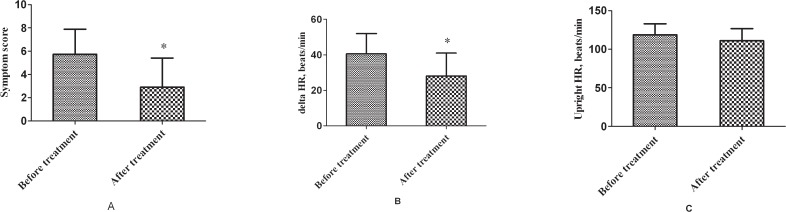
Symptom scores and heart rate changes of patients with POTS after metoprolol treatment.Compared to the symptom scores before treatment, the scores were significantly decreased after treatment in 34 children with POTS [(5.7 ± 2.2) vs. (2.9 ± 2.5), t = 9.232, P <0.001)]. Twenty-three patients repeated the head-up test, showing that the increment in heart rate induced by postural changes was significantly reduced after treatment [(41 ± 11) vs. (28 ± 13) beats/min, t = 3.476, P = 0.002]. * P < 0.01 compared with before treatment.